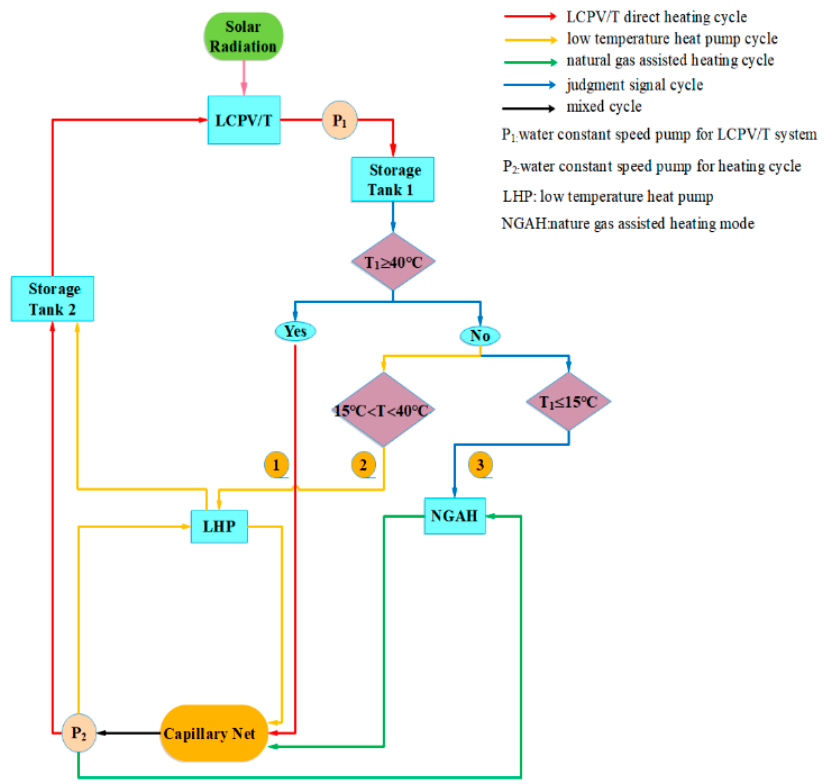
Figure 2. Schematic diagram of the NG-LCPV / T-TG system heating mode.